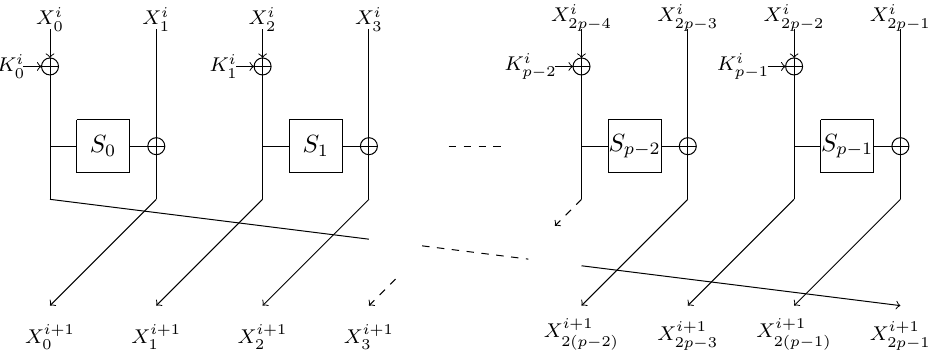
Figure 2: Example of cryptographic keyed functions for a Type-II Feistel